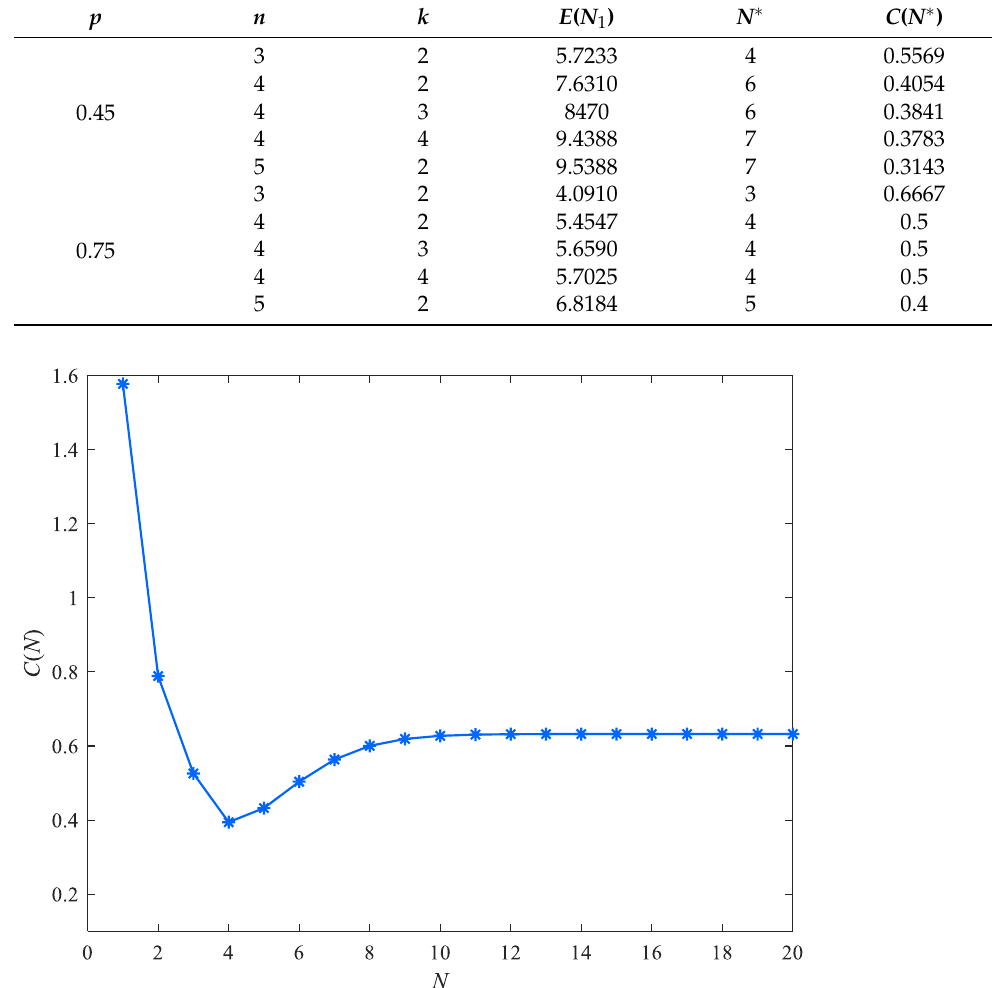
Table 3. Optimal solution with different parameters when c p = 2, c f = 5, λ = 0.55, δ = 2, m 1 = 1.